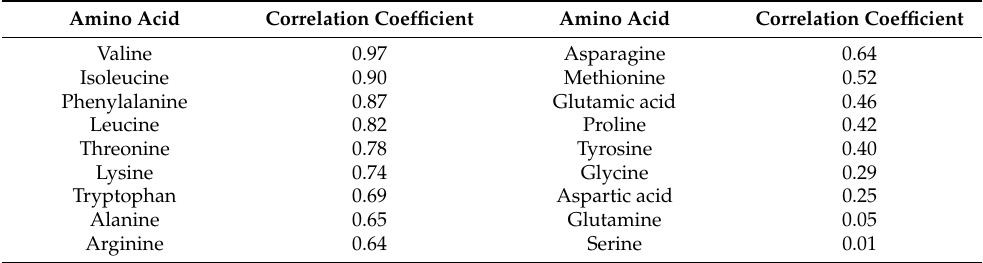
Table 3. Correlation coefficients of amino acid concentration in the final wort and soluble nitrogen